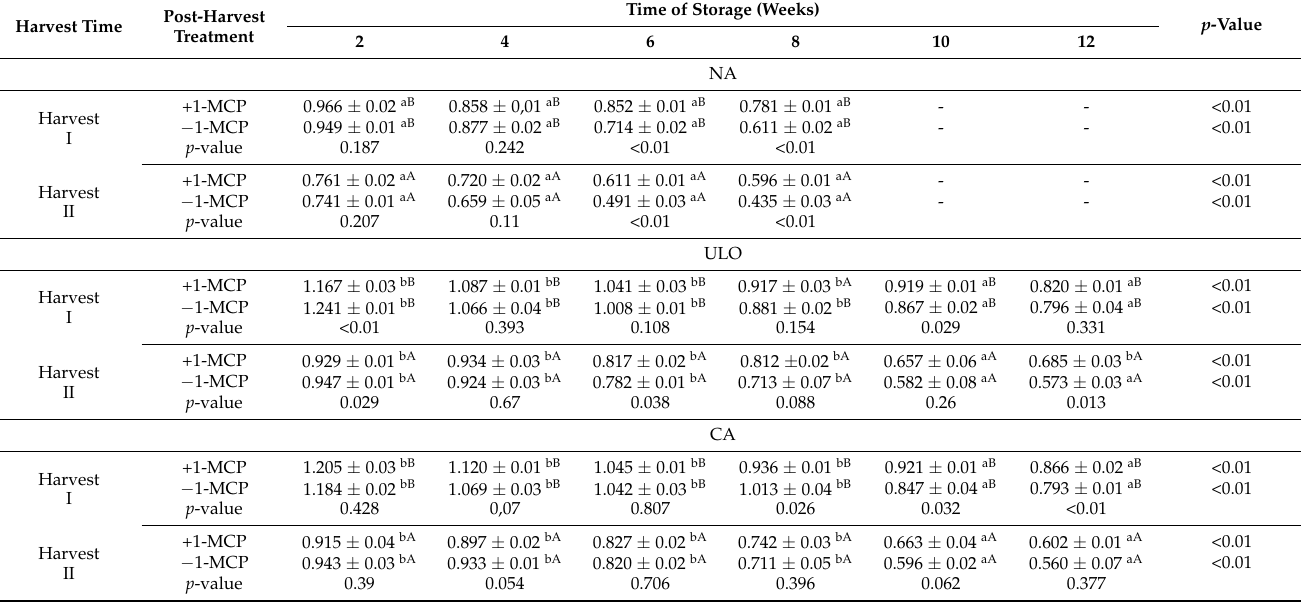
Figure 6. Titratable acidity of ‘Ananasnaya’ fruit (%) depending on harvest time and 1-MCP treatment under three storage technologies. Statistically significant difference between first and second harvest fruit (Newman–Keuls range test): *—for 5%. **—for 1%. Different letters were assigned to statistically significant differences when comparing the effect of 1-MCP, separately for storage conditions. Table 6. Changes of titratable acidity (%) measured in ‘Geneva’ mini kiwi fruit in the post-harvest period.